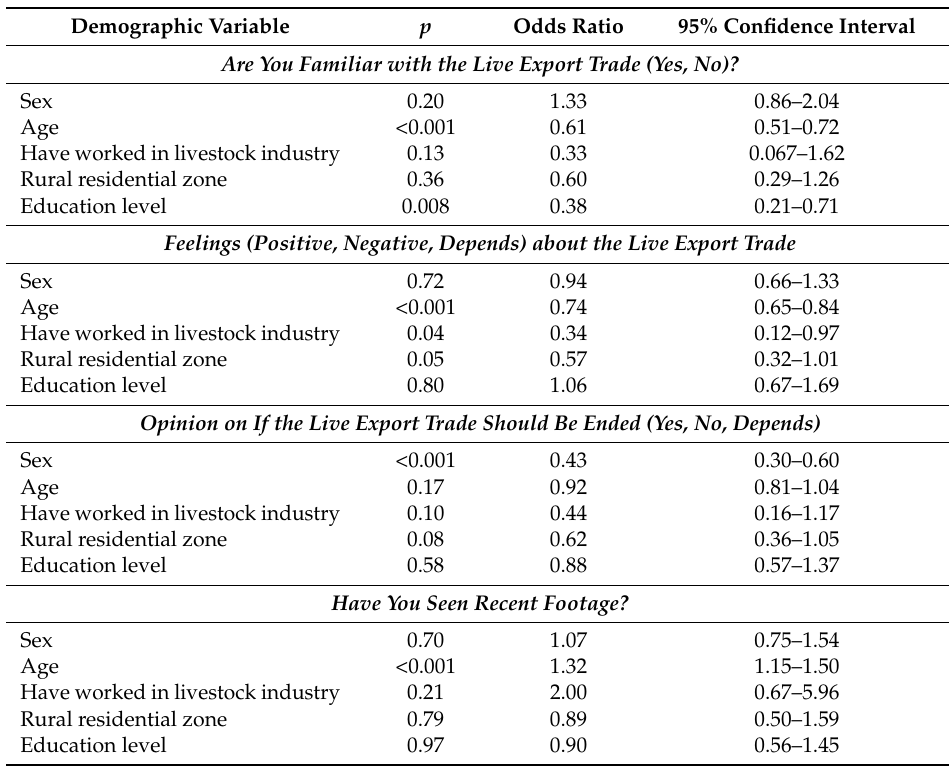
Table 6. Probabilities, Odds ratios and 95% confidence intervals for demographic effects on attitudes towards live export, analysed by logistic regression.